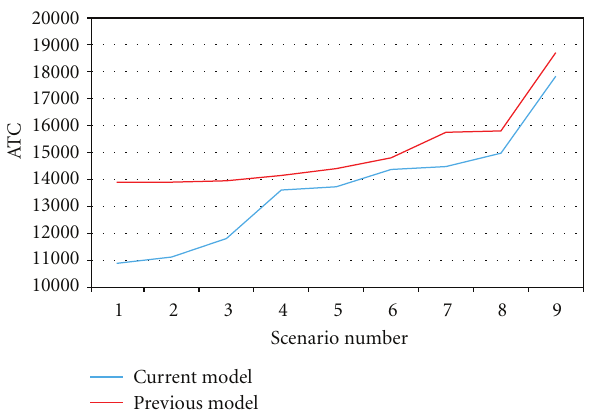
Figure 11: Compare current model with previous study under impact of customer di ff erentiation on the inventory